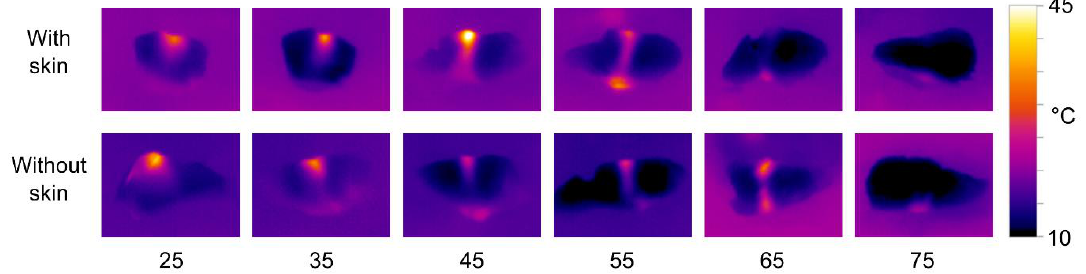
Figure 12. Thermal images of cod samples treated with the 1 MHz transducer for 15 s. The transducer-sample distance is listed below each set of images.